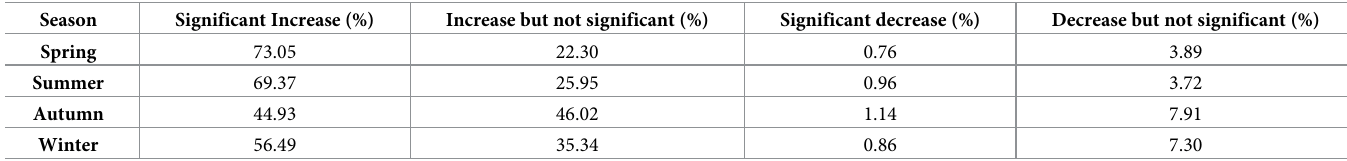
Table 2. Proportion of the area for seasonal NDVI